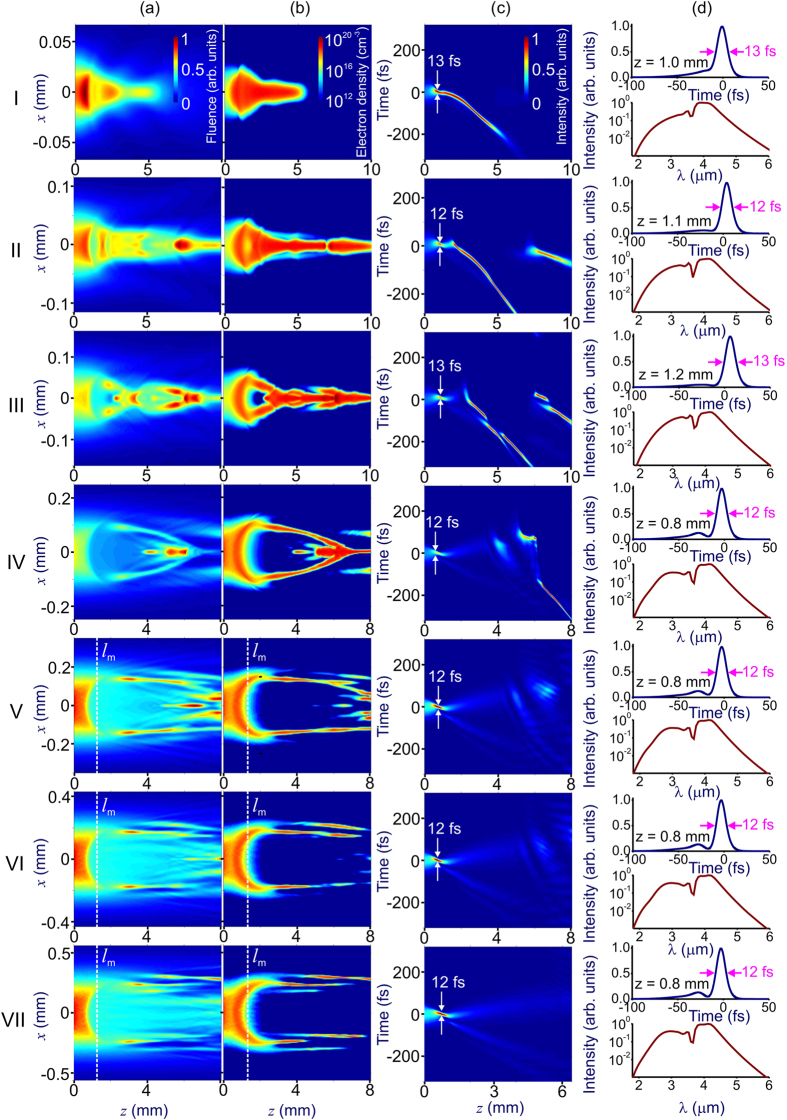
Spatiotemporal (3 + 1)-dimensional dynamics of a laser pulse with the central wavelength λ0 = 3.9 μm and the initial pulse width τ0 = 80 fs in an anomalously dispersive nonlinear medium: (a) the radial distribution of the field intensity integrated over the pulse as a function of the propagation coordinate, (b) electron density in the wake of the pulse, (c) spatiotemporal evolution of the field intensity, and (d) temporal envelope (top) and the spectrum (bottom) of the pulse on the beam axis at the point of maximum pulse compression. The peak power, P, energy, W, and beam diameter, d, of the input laser pulse are P = 5Pcr, W = 13 μJ, d = 70 μm (row I), P = 15Pcr, W = 40 μJ, d = 120 μm (row II), P = 30Pcr, W = 75 μJ, d = 170 μm (row III), P = 100Pcr, W = 0.25 mJ, d = 260 μm (row IV), P = 200Pcr, W = 0.5 mJ, d = 370 μm (row V), P = 300Pcr, W = 0.75 mJ, d = 450 μm (row VI), and P = 500Pcr, W = 1.25 mJ, d = 590 μm (row VII).